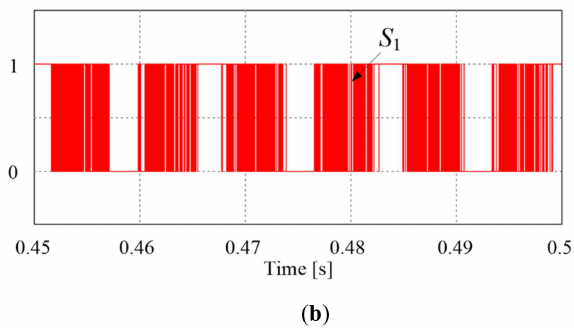
Figure 6. Simulation results of three-phase source currents, a -phase source voltage, and a -phase upper switch obtained from the ( a ) conventional algorithm and ( b ) the proposed algorithm.